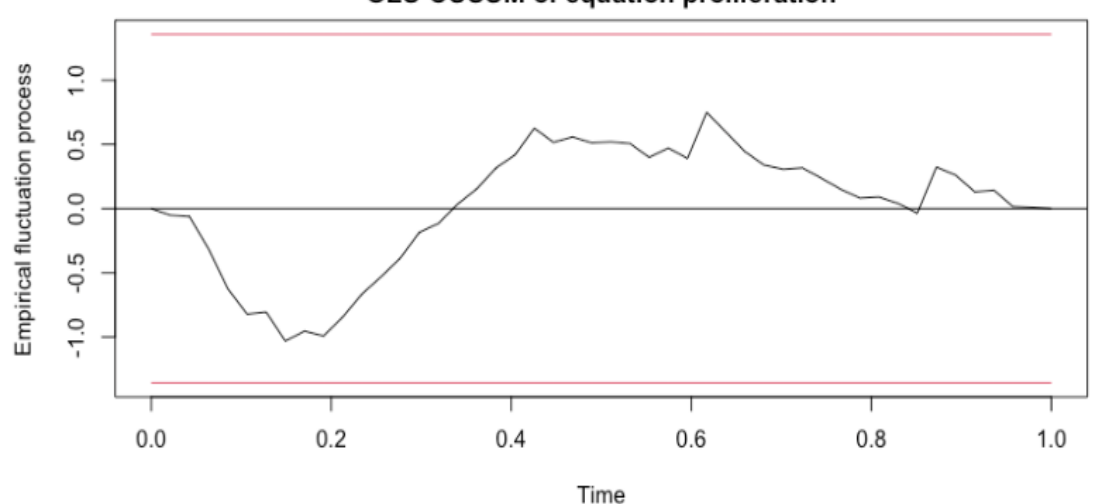
Figure 2. Plot of the Stability Test Output. Example plot showing the stability test outcome for the 3 min MDA-MB-231 Ki-67 model. CUSUM processes were calculated to detect structural changes in the inputted data.